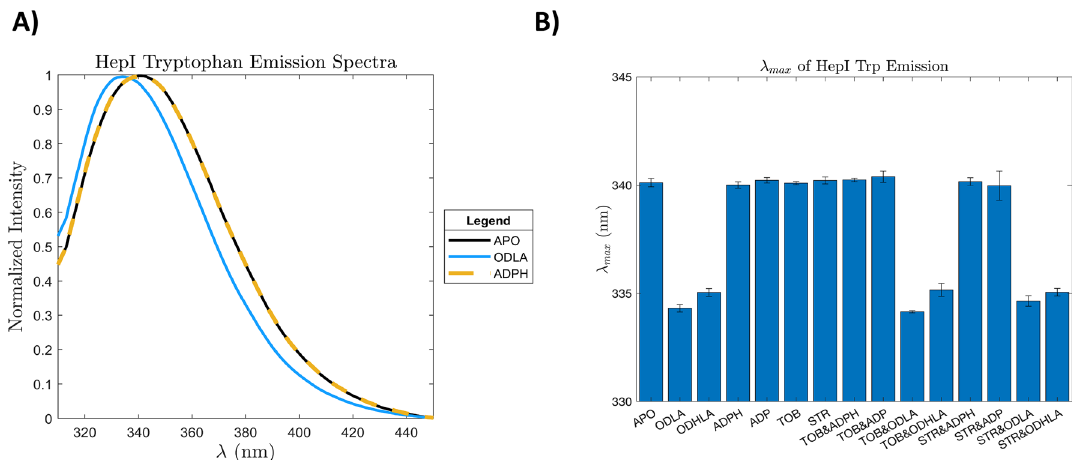
Figure 5. HepI tryptophan fluorescence emission ( A ) spectra and ( B ) λ max in the presence/absence of substrates, products and